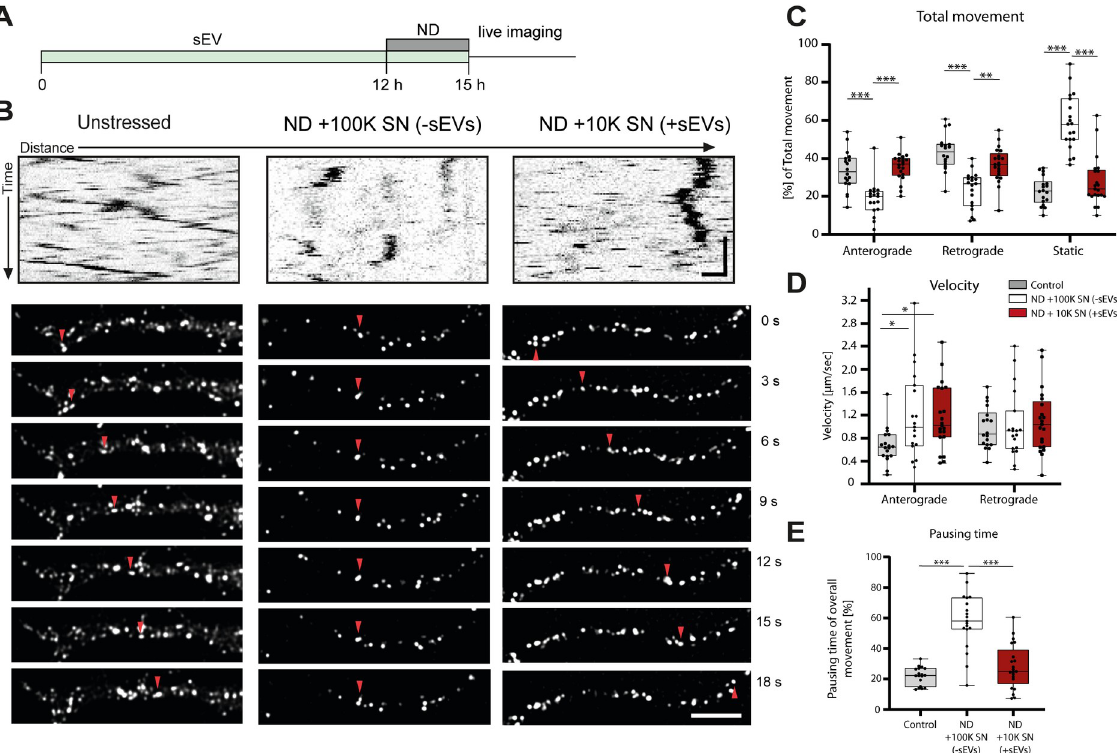
Fig 2. Influence of sEVs on axonal transport under starvation stress. (A) Illustration of experimental schedule. Hippocampal neurons were treated with sEVs and subjected to starvation stress by depletion of B27 supplement (nutrient deprivation) during the last 3 h before live imaging. All treatment conditions were identical regarding the presence of oligodendrocyte-derived soluble factors and differed in presence of sEVs. (B) Representative kymographs and corresponding time-lapse frames illustrating movement of BDNF-mCherry-positive vesicles generated from hippocampal neurons exposed to nutrient deprivation. Neurons were kept in complete medium (unstressed) or subjected to nutrient deprivation in the absence [ND + 100K SN ( − sEVs)] or presence of sEVs [ND + 10K SN (+sEVs)]. Red arrowhead follows 1 distinct particle moving over time. Kymograph: horizontal scale bar = 5 μ m, vertical scale bar = 10 s; fluorescent picture frames: scale bar = 5 μ m (C– E). Quantitative analysis of kymographs regarding total movement (C), velocity (D), and pausing time (E) of BDNF-mCherry-positive vesicles. Data are presented as median, boxes (25th percentile to 75th percentile), and whiskers (minimum to maximum showing all data points), n = 18 recorded neurons for control, n = 19 for ND + 100K SN ( − sEVs), n = 21 for ND + 10K SN (+sEVs), from 3 independent experiments. � p < 0.05, �� p < 0.01, ��� p < 0.001, Shapiro–Wilk normality test following Kruskal–Wallis test with Dunn’s multiple comparison test. Underlying data can be found in S1 Data. 10K, 10,000 g- centrifuged; 100K, 100,000 g- centrifuged; ND, nutrient deprivation; sEV, small extracellular vesicle; SN,